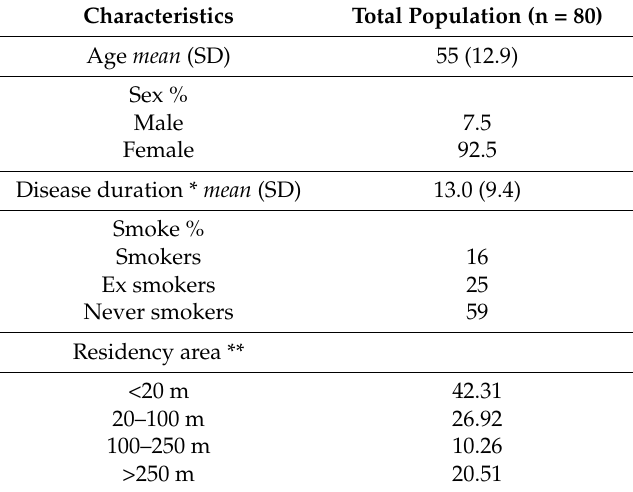
Table 1. Patient characteristics.